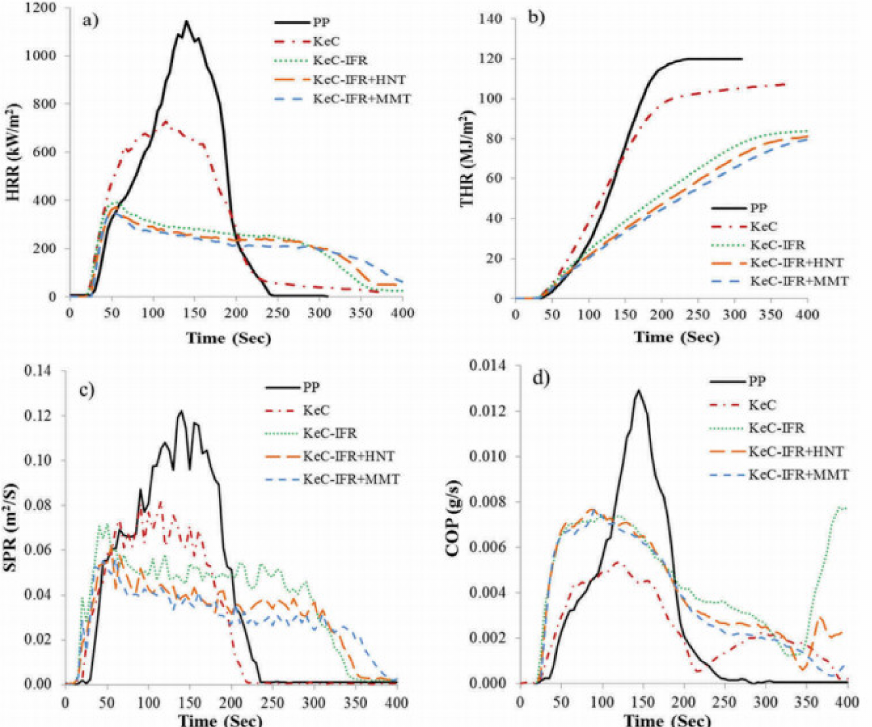
Figure 6. Flammability analysis by cone calorimeter: ( a ) HRR, ( b ) THR, ( c ) SPR, and ( d ) (COP). Reproduced from